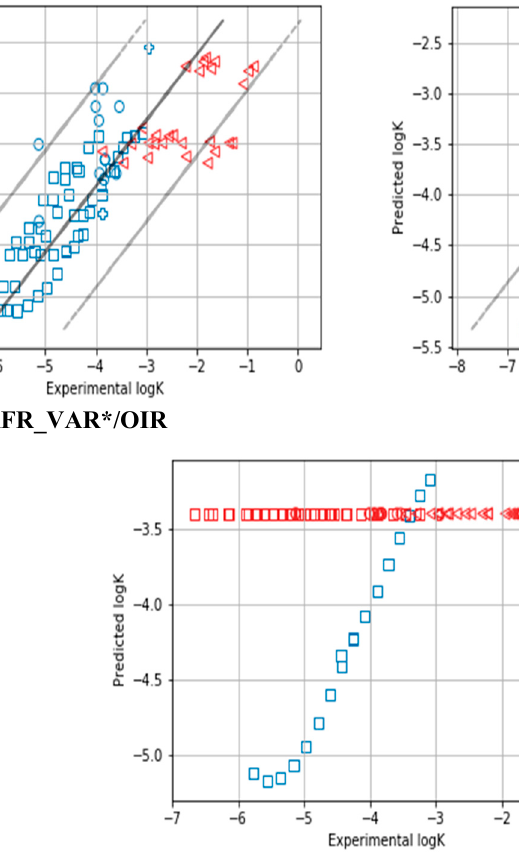
Figure 4. Validation of the model on the external test set: predicted vs. experimental logk. Blue datapoints are reactions within AD (X-inliers); red datapoints are outside AD (X-outliers). Reactions with di ff erent reaction centers are specified by di ff erent shapes of points: reactions with phenylsulphonate leaving group for which rate constants were predicted badly by ML methods are shown as triangles. Reactions with chlorine leaving group are shown as circles, bromine leaving group—as crosses, iodine leaving group—as squares .